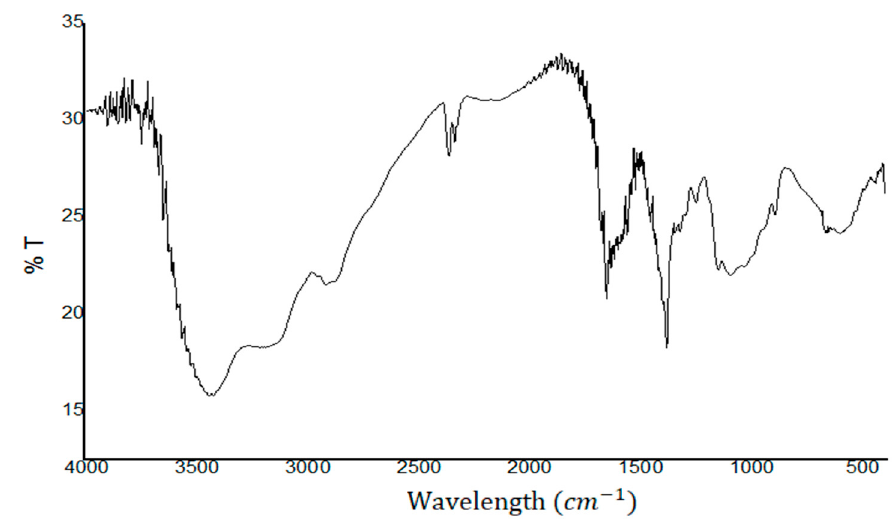
Figure 1. Fourier transform infrared spectrum of extracted chitosan.